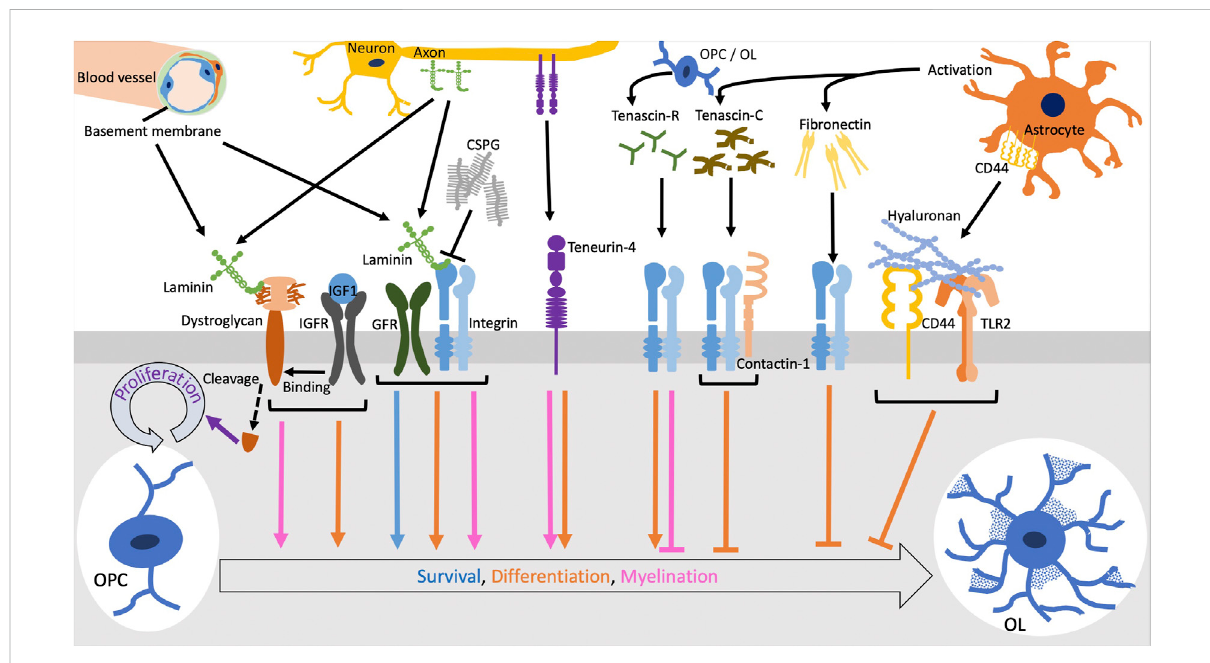
FIGURE 1 The functions of ECM molecules through cellular receptors. Laminins expressed in vascular basement membrane or along axons promote survival and differentiation of oligodendrocytes (OLs) and myelination via integrins in coordination with growth factor receptors (GFRs). Chondroitin sulfateproteoglycans(CSPGs)formaggregatesandinhibitthelaminin-integrinsignaling.Thecleavageofdystroglycandownstreamofthebindingto laminin induceOLprecursorcell(OPC) proliferation.OLdifferentiationandmyelinationbythelaminin-dystroglycanbindingisenhancedwhen dystroglycan interacts with the complex of insulin-like growth factor (IGF1) and IGF receptor (IGFR). Tenascin-R and teneurin-4 promotes differentiation of OLs while tenascin-C inhibits it via the interaction of integrins with contactin-1. Fibronectin aggregation secreted by activated astrocytes negatively regulates OL differentiation. Also, hyaluronan inhibits OL differentiation through the TLR2